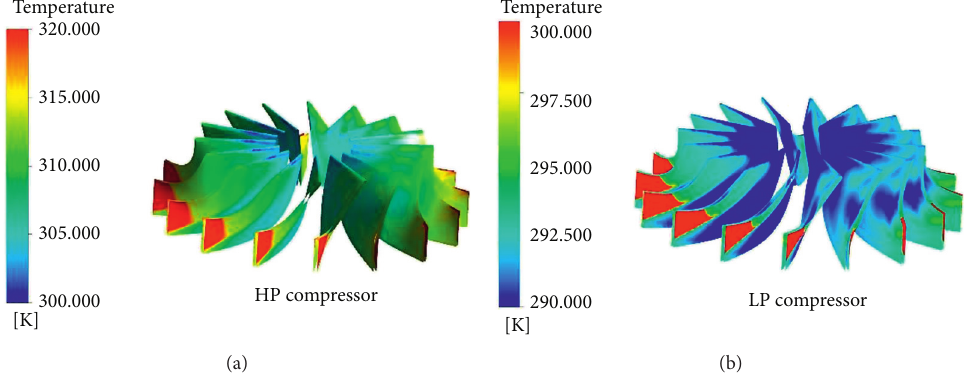
Figure 13: Contour of temperature for (a) HP Compressor (b) LP